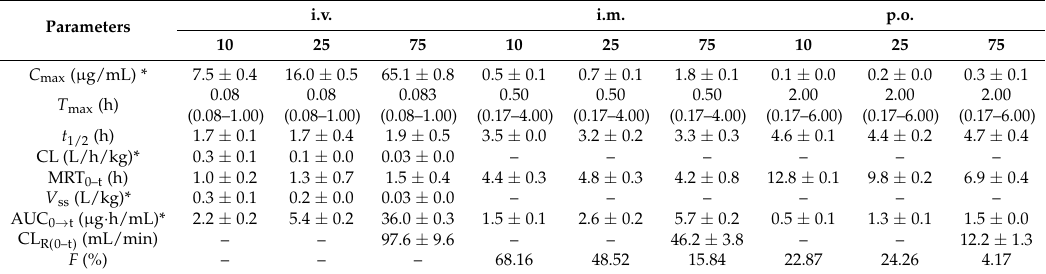
Table 5. Pharmacokinetic parameters of DPTM in serum after i.v., i.m. and p.o.